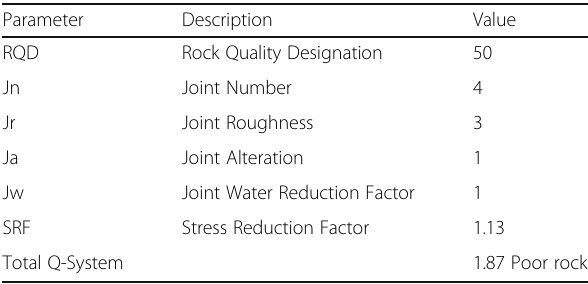
Table 5 Rock Tunneling quality index, Q-system determined as